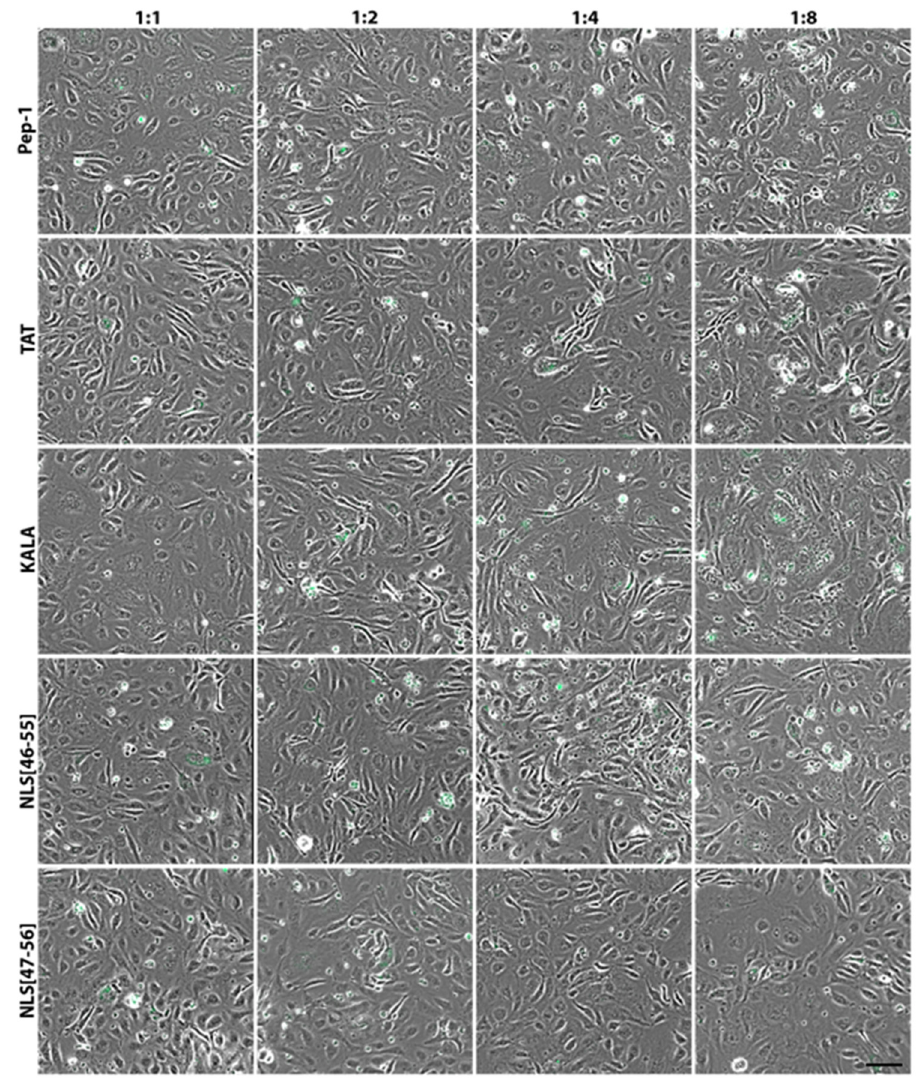
Figure 15. Effect of 48 h culture in the presence of complexes in CRs of 1:1, 1:2, 1:4 and 1:8. The complexes were formed using incubation of 2 μ g pmaxGFP with chosen CPPs at 21 °C for 15 min. Bar = 50 μ m. CR, charge ratio. ( A ) Transfection efficiency. ( B ) Percent of cells with abnormal mor- phology. Data are presented as means, numbers in parentheses represent standard deviations.